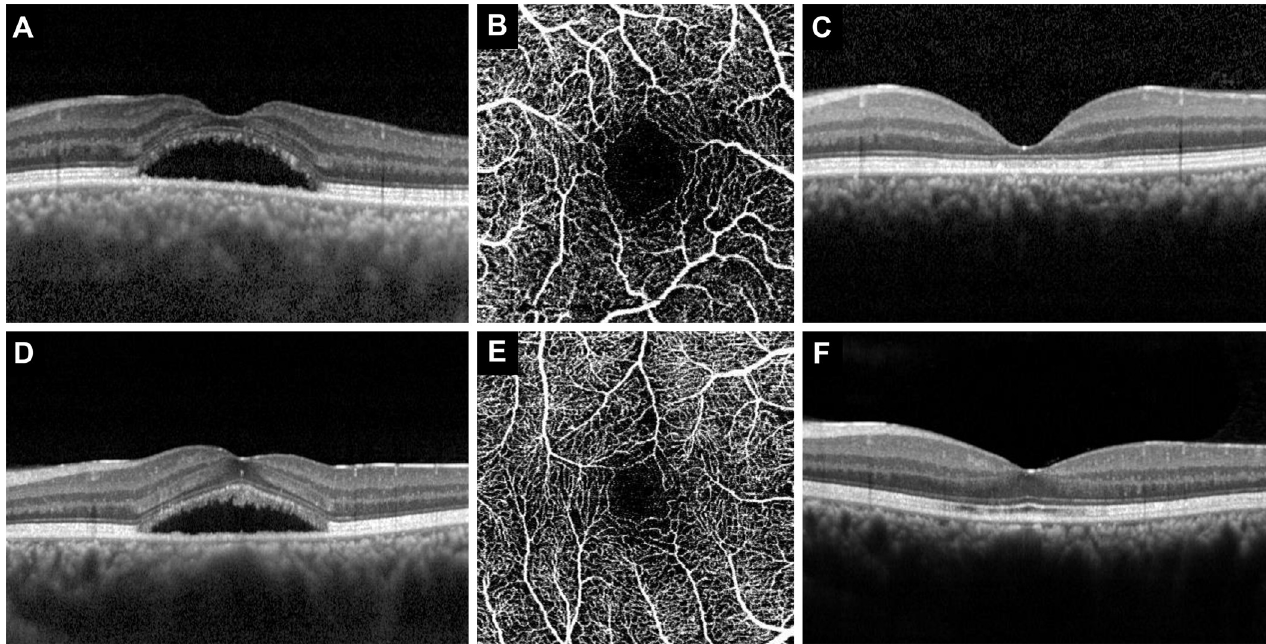
Fig 2. Horizontal section of OCT image and OCTA image of SCP of a 67-year-old man in the incomplete recovery group (A, B, C) and 63-year-old man in the complete recovery group (D, E, F). Compared with the 67-year-old man (incomplete recovery group), the 63-year-old man (complete recovery group) had better BCVA at baseline and 6 months after PDT (logMAR BCVA, 0.05 vs. 0.22 and 0.05 vs. 0.10, respectively), and shorter symptom duration (4 months vs. 7 months, respectively). Moreover, the central foveal thickness before (A, D) and after (C, F) PDT was thicker (182 μ m vs. 145 μ m and 201 μ m vs. 135 μ m, respectively), and the SCP FAZ area (B, E) before PDT was narrower (0.22 mm 2 vs. 0.32 mm 2 ,